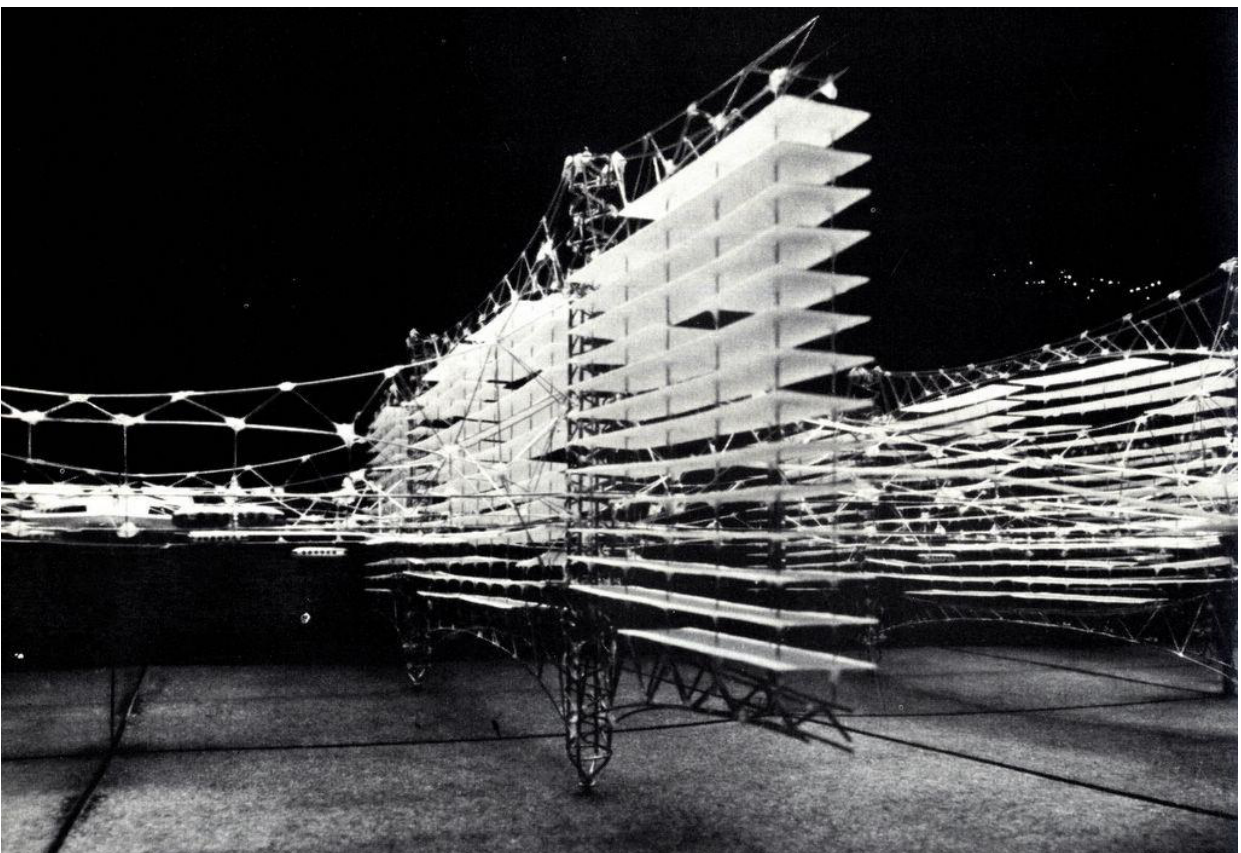
Figure 6. Takis Ch. Zenetos, physical model for the “Suspended city” (“Ville suspendue”), 1961. Image courtesy of the Takis Ch. Zenetos Archive.